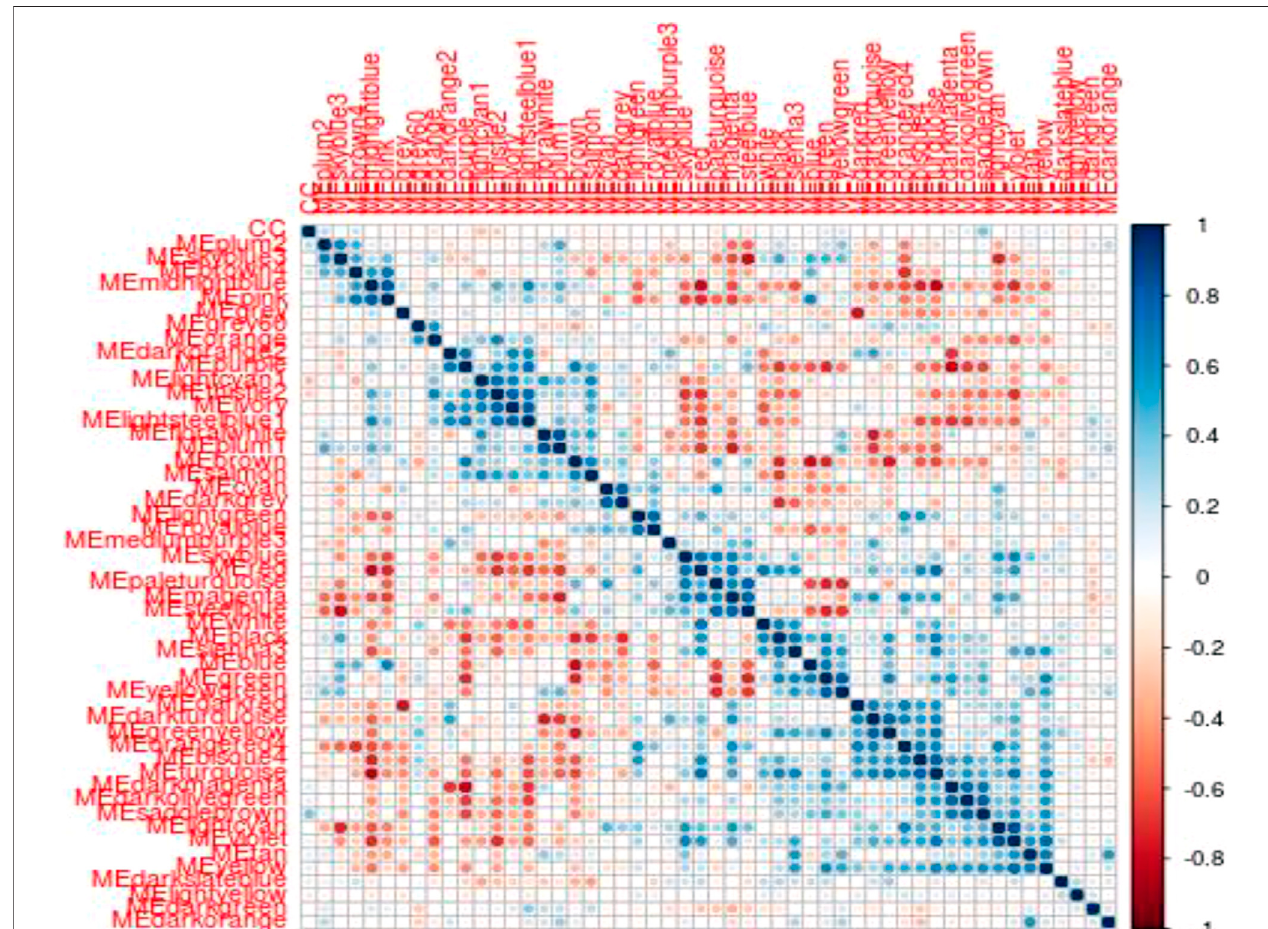
FIGURE 2 | Eigengene heatmap: The scatterplots of MM vs. GS in saddlebrown module exhibited very signi fi cant positive correlations.